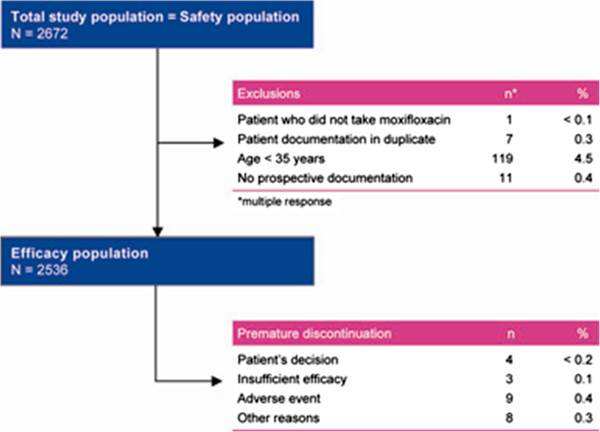
Patient disposition.